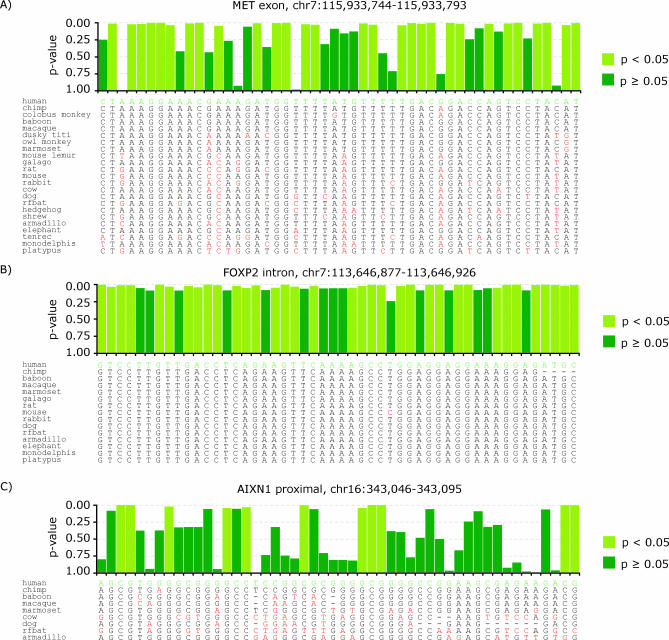
Examples of SCONE p-Value Scores for Coding (A), Highly Conserved Noncoding (B), and Nonconserved RegionsPositions likely to be conserved (p < 0.05) are in light green; other positions are dark. Below each plot is the portion of the multiple sequence used to generate scores for each sequence region. Deviations from human sequence (green) are indicated in red.(A) A portion of an exon from the MET gene (chr7:115,933,744–115,933,793). The pattern of conserved positions is indicative of the triplet structure of the genetic code.(B) A highly conserved intronic sequence in the FOXP2 gene (chr7:113,646,877–113,646,926).(C) An intergenic region near the AXIN1 gene (chr16:343,046–343,095) showing little overall conservation, but containing a significant number of individually conserved positions.